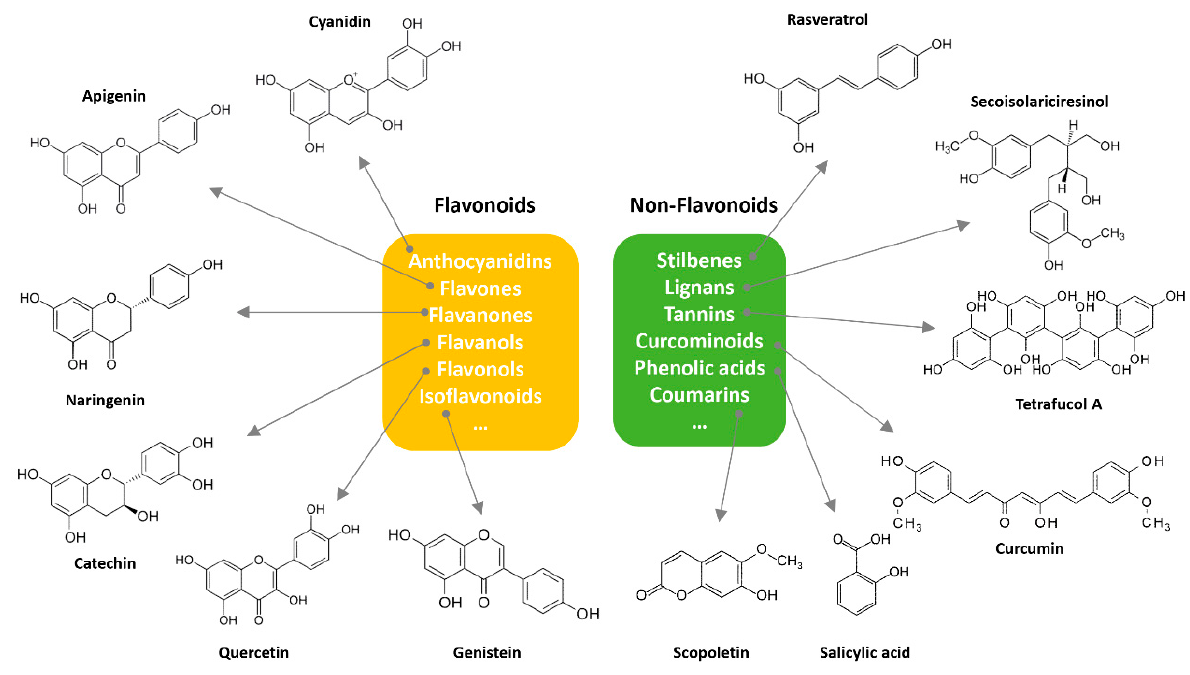
Figure 1. Classification of PPs with some representative examples.